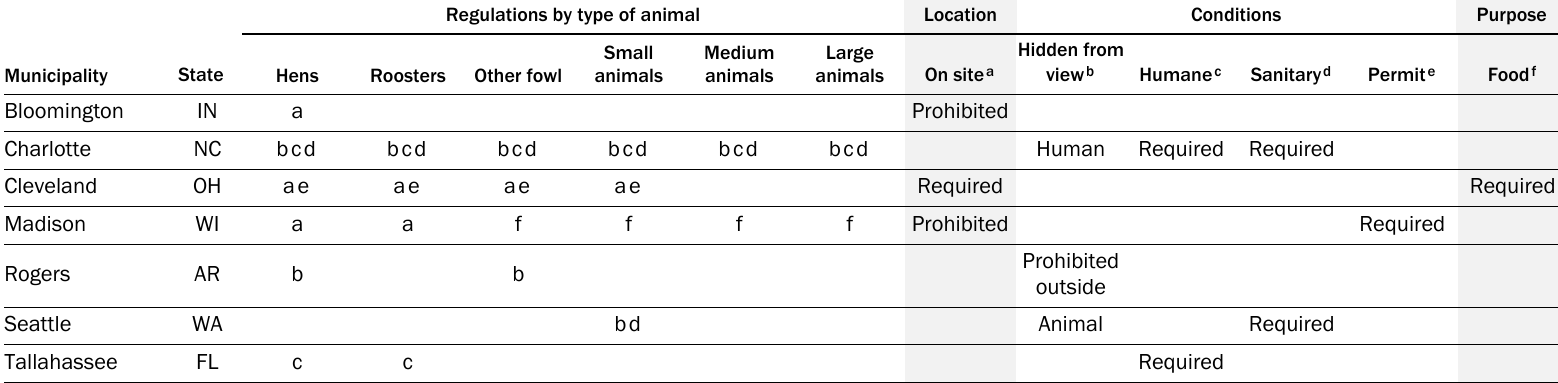
Table 3. Slaughter Regulations Dependent on Variables of Location, Conditions, and